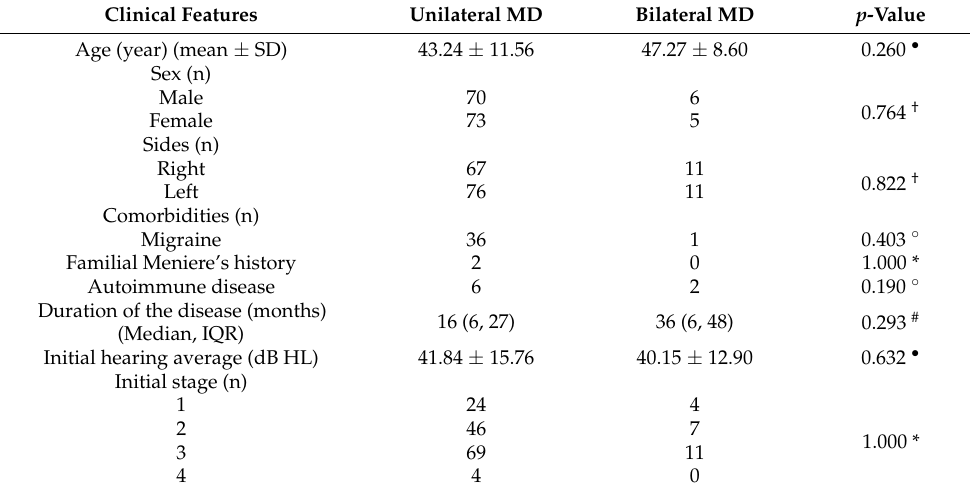
Table 1. Overview of the patients with definite Meniere’s